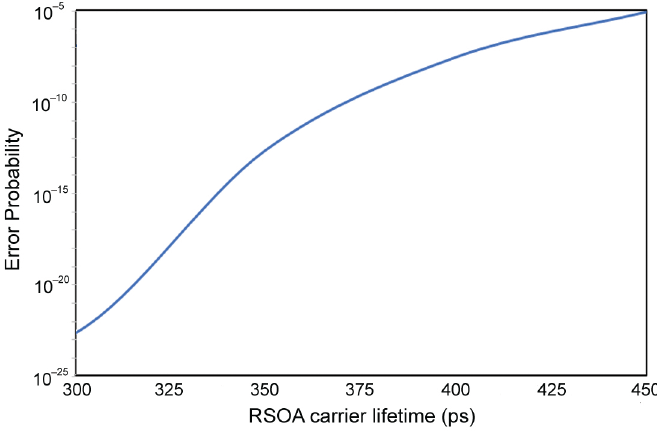
Figure 12. Error probability vs. RSOA carrier lifetime.